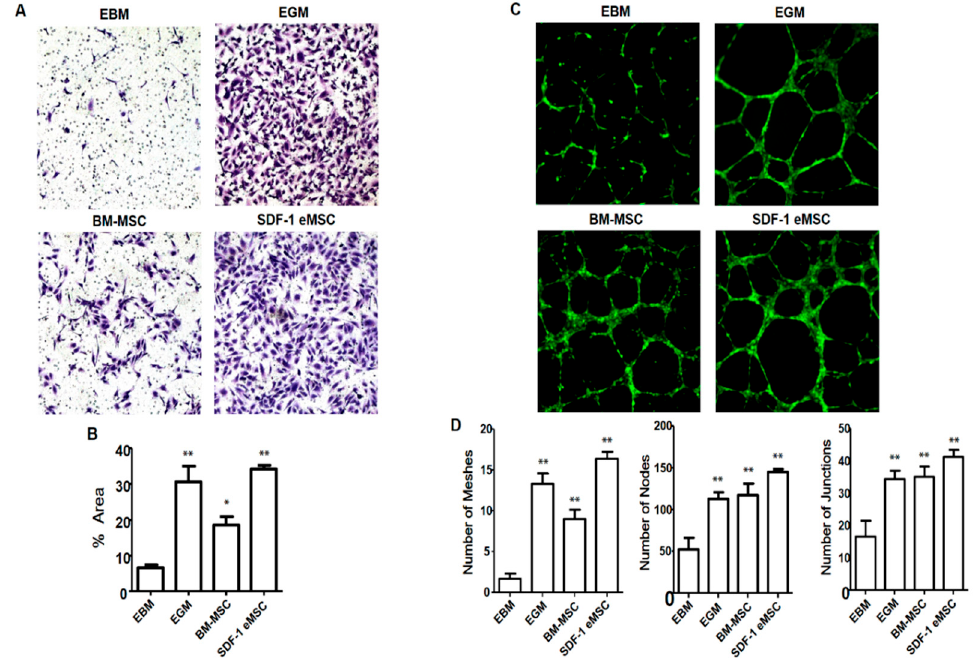
Figure 8. ( A ) Microscopic fields showing migrated HUVECs at the bottom of the PET membrane; ( B ) Bar graph representing the percentage of migrated HUVECs per migrated field in response to BM-MSCs and SDF-1 eMSCs. SDF-1 eMSCs had a greater chemotactic effect than BM-MSCs. Original magnification: × 100; ( C ) Fluorescence microscopy images showing the formation of the tube network on the Matrigel matrix. BM-MSC- and SDF-1 eMSC-treated groups had greater capillary-like structures than EBM-treated groups; ( D ) Quantitative results for total meshes, total nodes, and total junctions in each group. Original magnification: × 50. * p < 0.05 compared with the DM ED group. ** p < 0.01 compared with the DM ED group.